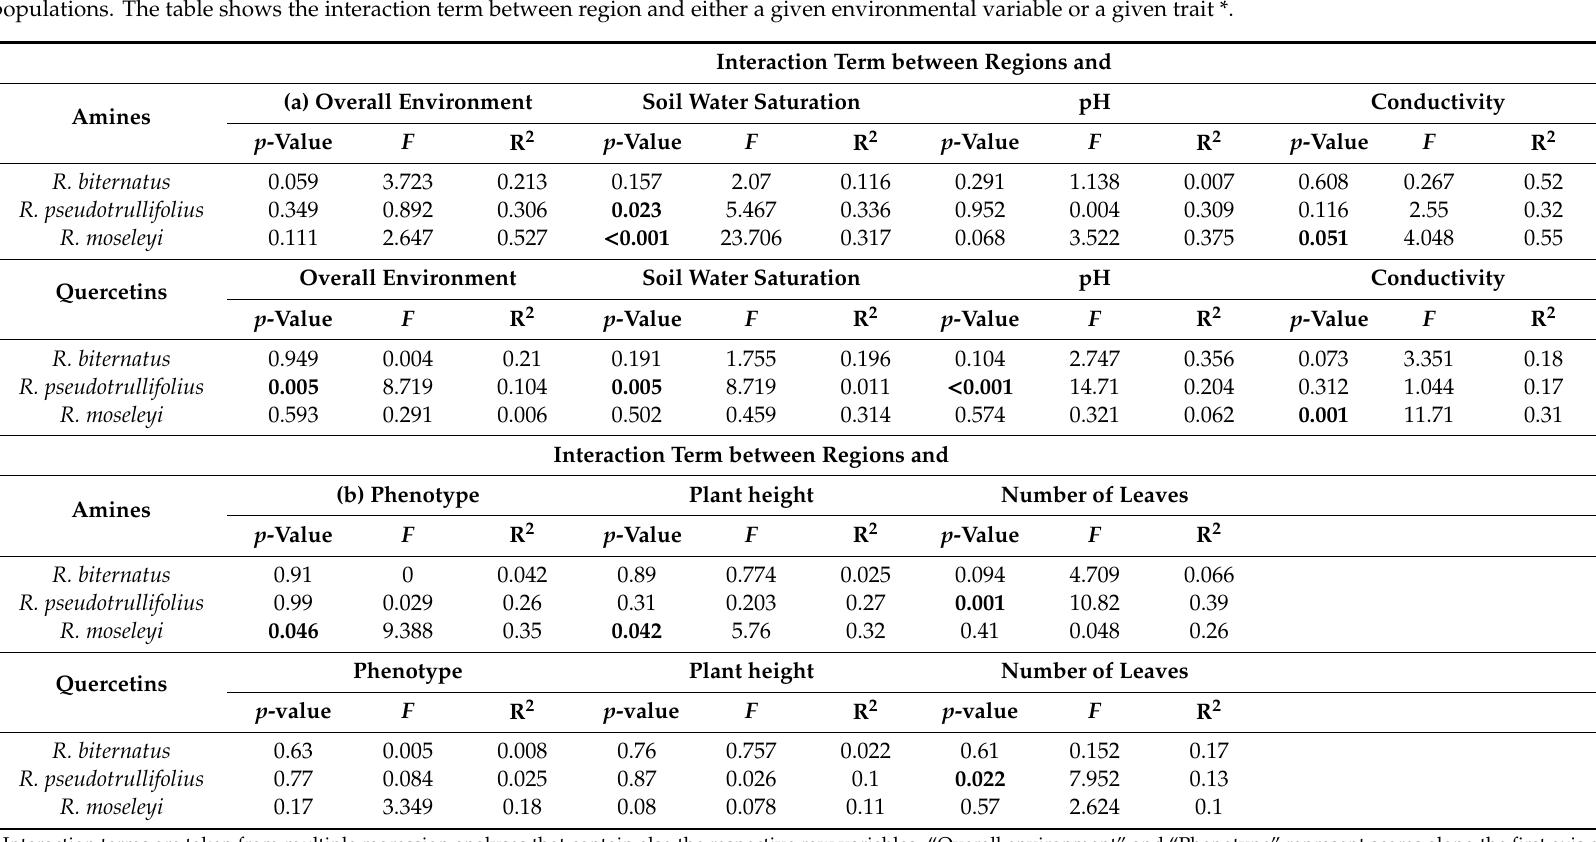
Table 5. E ff ects of region on the relationships between total metabolite contents (amines or quercetins) and ( a ) the environment, or ( b ) the phenotype among populations. The table shows the interaction term between region and either a given environmental variable or a given trait